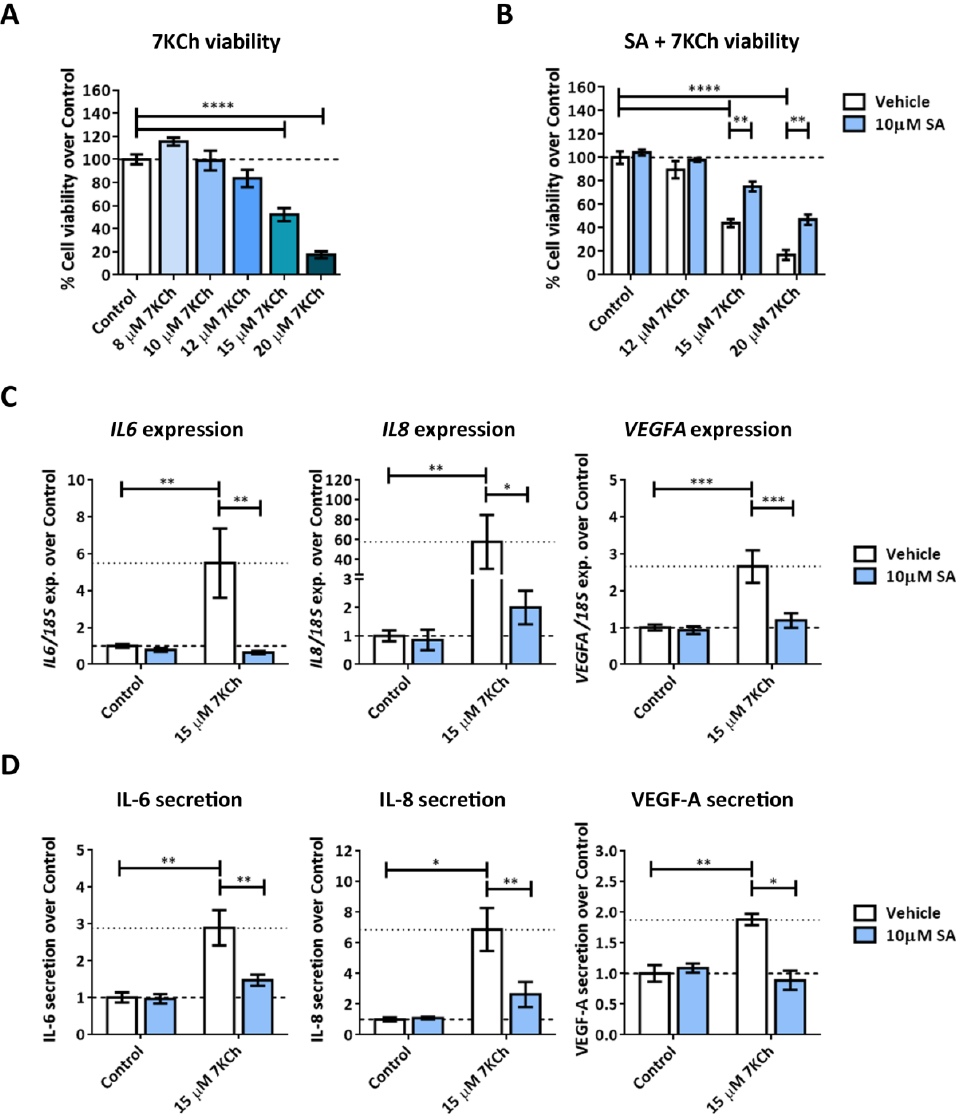
Figure 1. Cell toxicity and inflammation induced by 7KCh and protective effect exerted by SA on mRPE cells. ( A ) Cell viability determined by MTS assay in mRPE cells treated with increasing concentrations of 7KCh or with ( B ) 10 μM SA and 12–20 μM 7KCh for 24 h. ( C ) Quantification by qRT-PCR of IL6 , IL8 and VEGFA gene expression levels in mRPE cells treated with 15 μM 7KCh and 10 μM SA for 24 h, normalized with respect to rRNA 18S expression. ( D ) Secreted levels of IL-6, IL-8 and VEGF-A in mRPE cells exposed to 15 μM 7KCh and 10 μM SA for 48 h and measured by ELISA. The vehicle group in the graphs represents the control (control-vehicle) and the 7KCh (7KCh-vehicle) treatment. Data are represented as mean ± SEM of at least three different experiments. The dashed and dotted lines are a guidance mark of control and 7KCh value, respectively. ANOVA test was used for statistical analysis followed by Tukey (in A ) or Sidak (in B – D ) post hoc test. * p < 0.05; ** p < 0.01; *** p < 0.001; **** p < 0.0001.